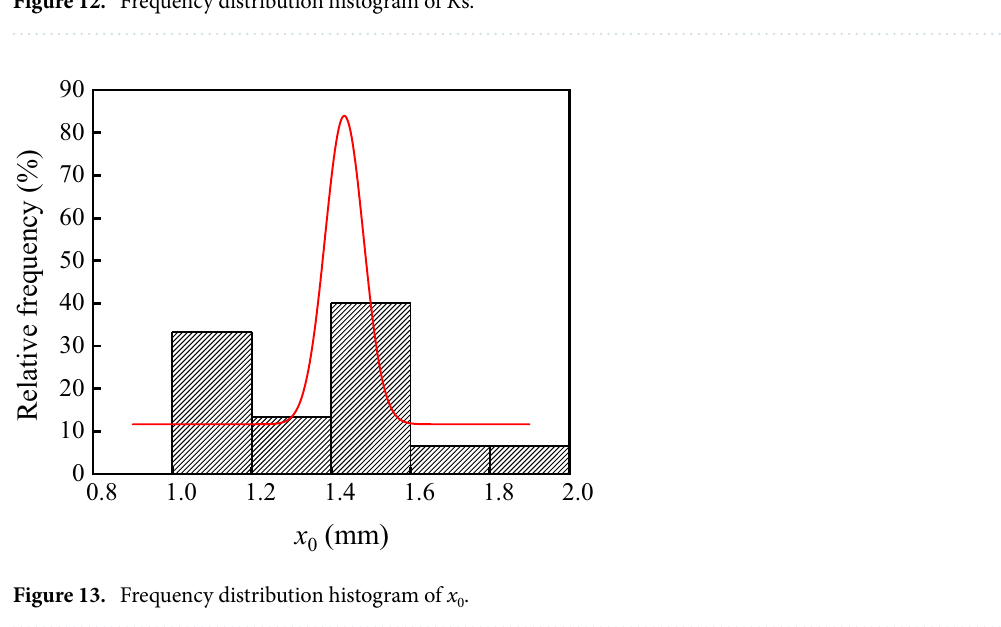
Figure 12. Frequency distribution histogram of K s.